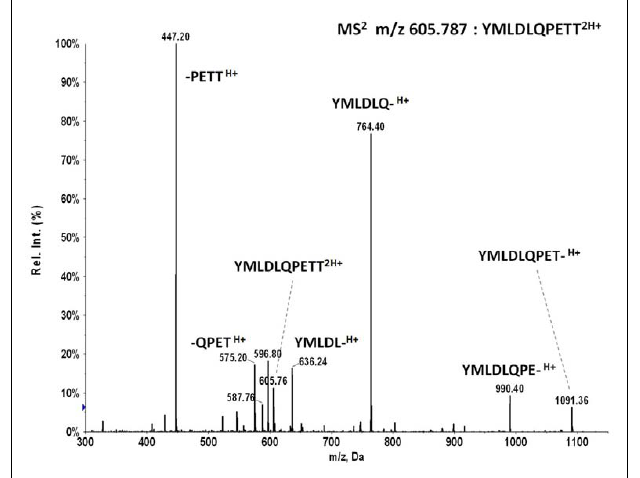
FIGUREA6 | MS 2 605.8 of synthetic peptideYMLDLQPETT generates a prominent b 6 ion fragmentYMLDLQ- which is used for MS 3 605.8/764.4 Poisson